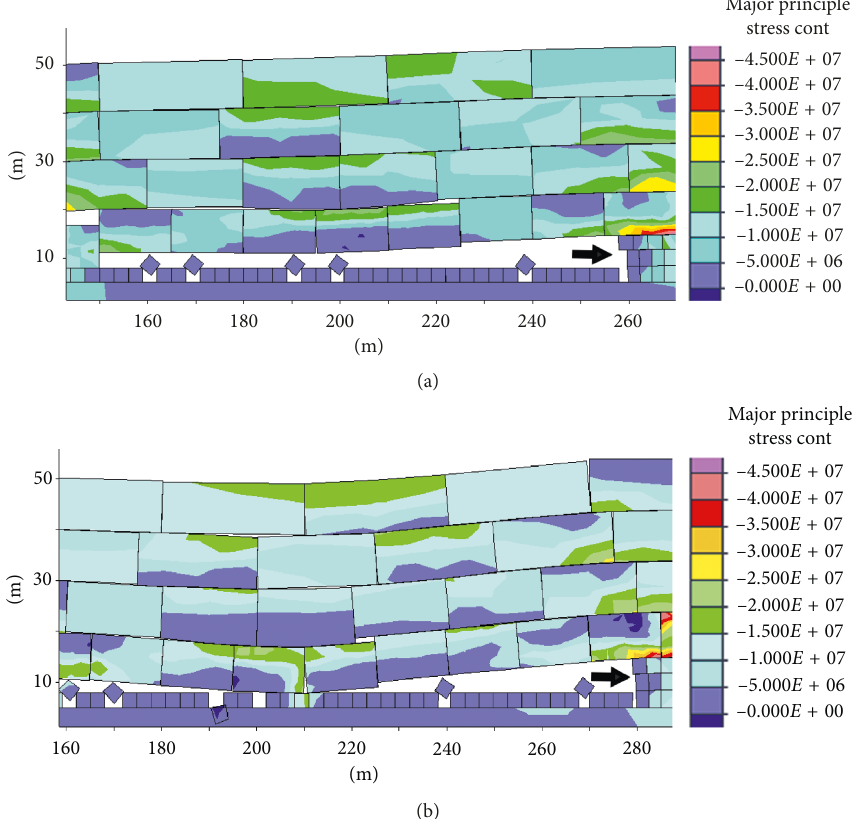
Figure 9: Evolution process of the step pressure-arch structure of the basic roof. (a) Step pressure-arch. (b) Instability of the pressure-arch of the basic